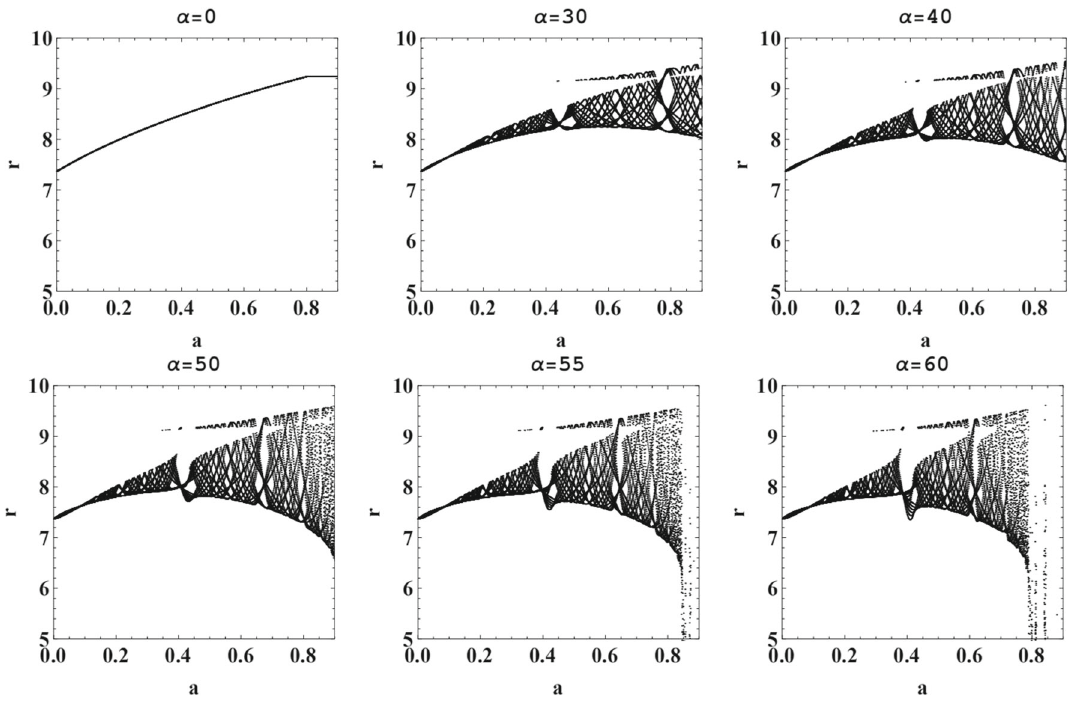
Fig. 10 The change of bifurcation with the spin parameter a for the signal in Fig.